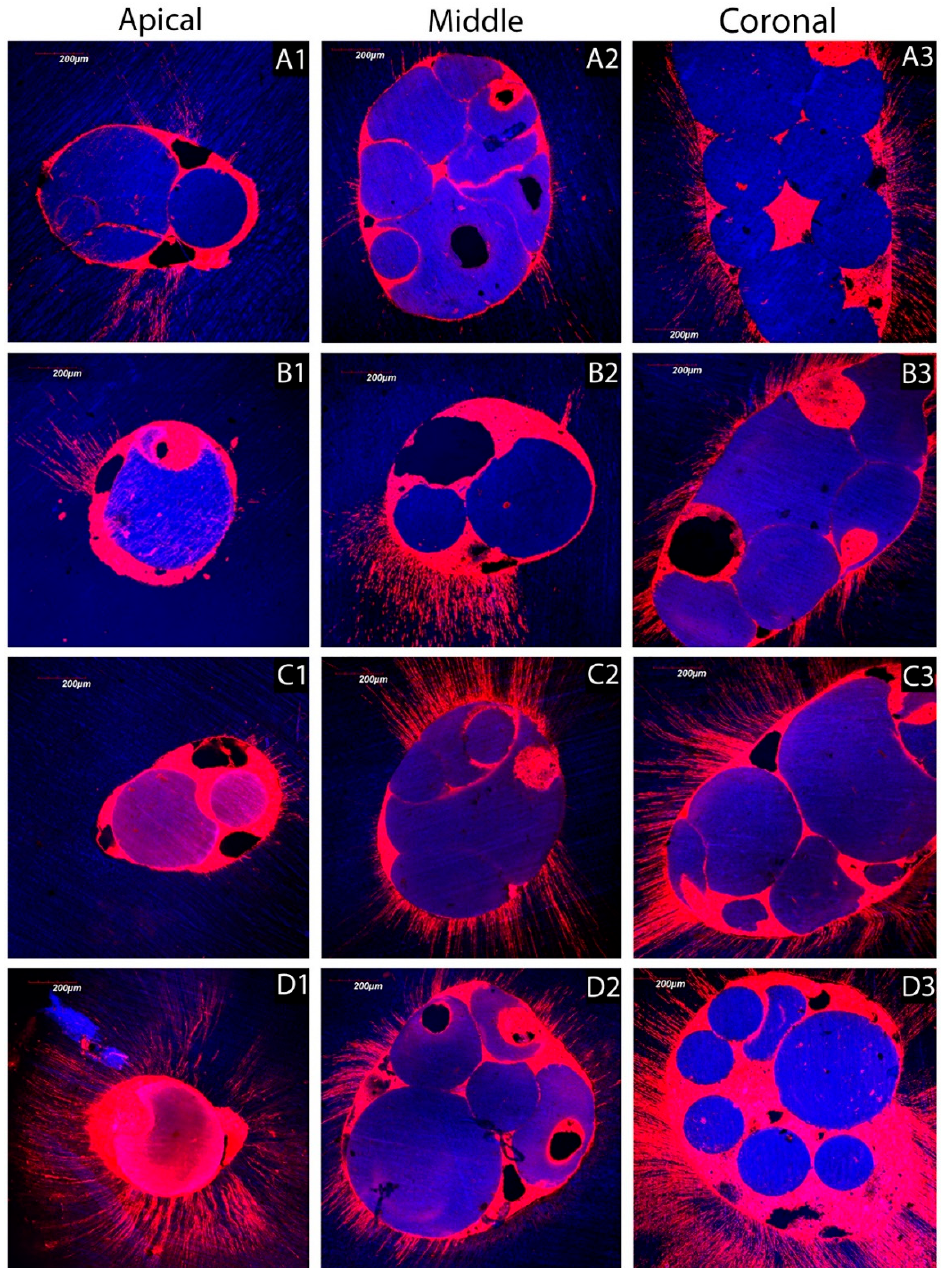
Figure 5. Confocal z-stack images converted into single-projection images, which show sealer penetration at different levels of the root canal dentin treated with the irrigation solutions tested in this study. ( A1 ) (apex), ( A2 ) (middle) and ( A3 ) (coronal) show the poor penetration of the sealer into the root canal dentin treated using the control PBS. ( B1 ) (apex) and ( B2 ) (middle) show an evident lack of penetration of the sealer in most of the root canal dentin treated using NaOCl, but with some more sealer penetration at the coronal level ( B3 ). ( C1 ) (apex) shows an evident lack of penetration of the sealer in particular at the apical level of the root canal dentin treated using EDTA. However, a decent sealer penetration is evident at middle ( C2 ) and coronal ( C3 ) dentin. ( D1 ) (apex), ( D2 ) (middle) and ( D3 ) (coronal) show a clear penetration of the sealer in root canal dentin treated using the BioAKT silver citrate irrigation agent.